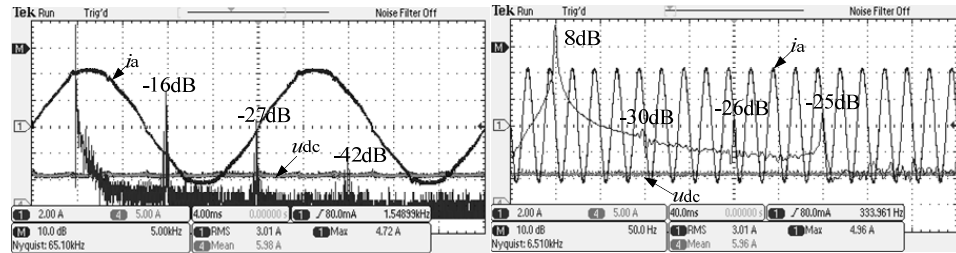
Figure 13. System AC current FFT analysis of traditional passive damping scheme.